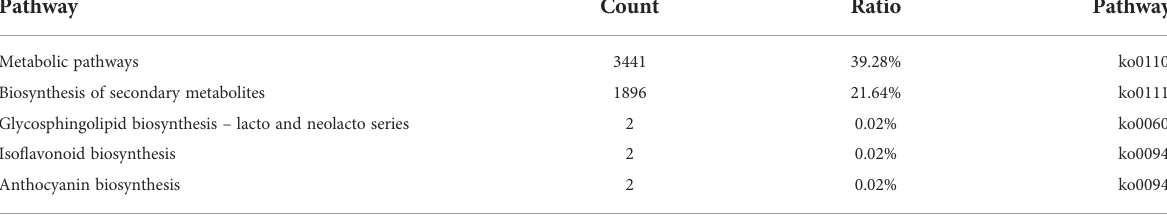
TABLE 3 KEGG pathways enriched with ‘ Taihang Mingzhu ’ unigenes.